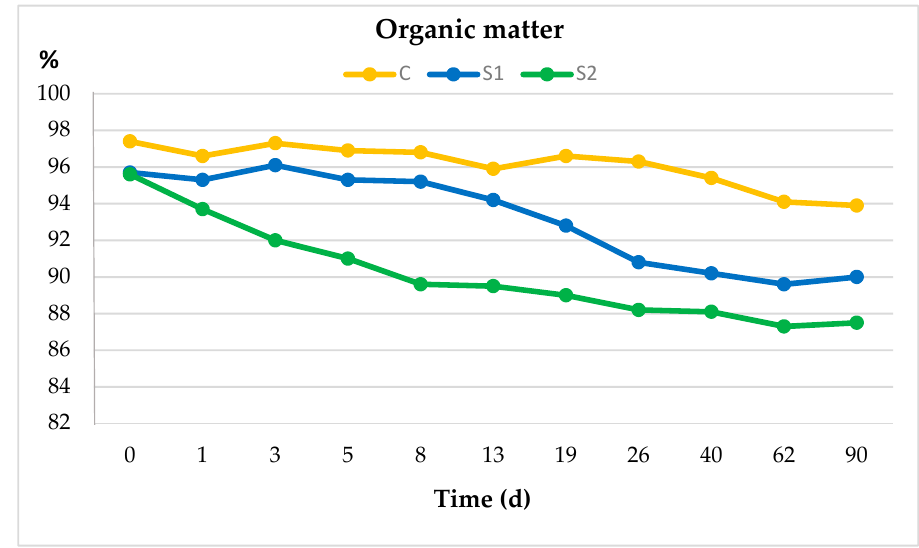
Figure 5. Organic matter degradation during composting.